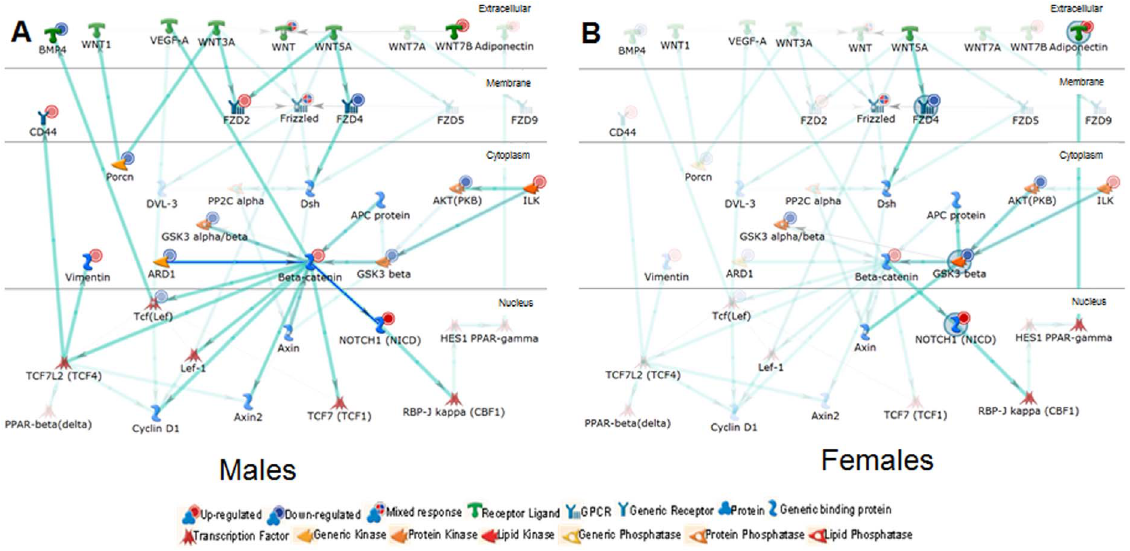
Figure 8. Alteration in Wnt signaling in cs-ER a 2 / 2 mice: Variations in WNT signaling in males (A) and females (B) in cs-ER a 2 / 2 mice as identified through microarray profiling and subsequent network mapping using MetaCore. The network is filtered for cardiac tissue in mice and in a layout based on sub-cellular localization from top to bottom. The traced and bolded network components represent the modified genes and the genes that are connected to them highlighting the difference observed in cs-ER a 2 / 2 mice of both